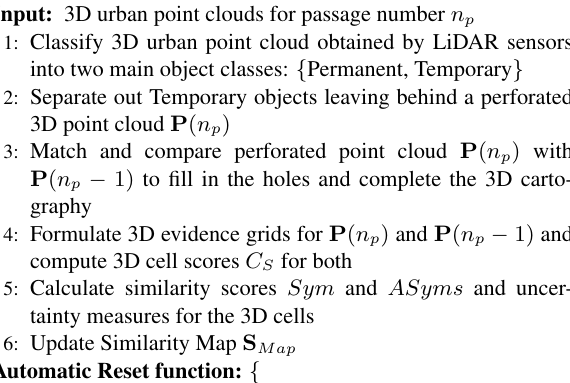
Figure 1: Classification of the objects present in the urban scene into 3 main